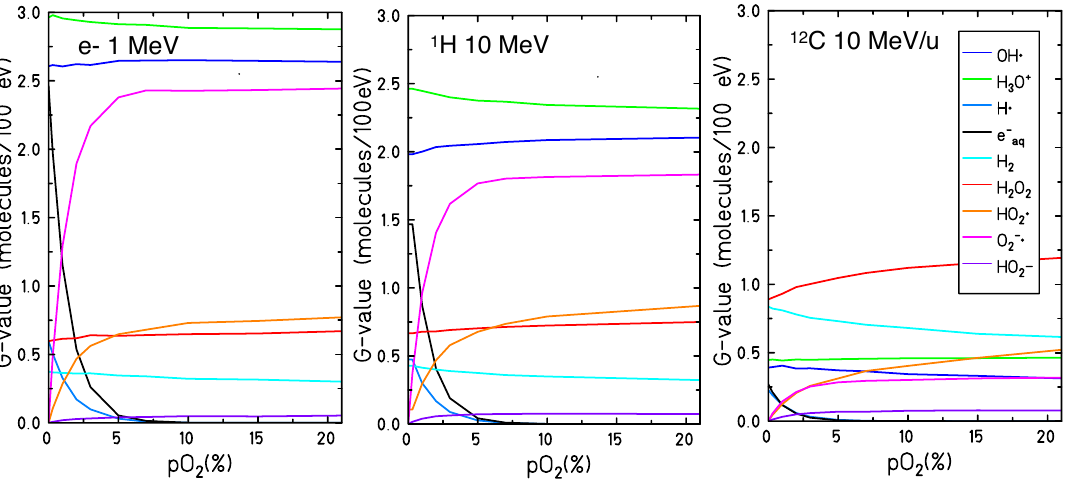
Figure 4. Radiolytic yields, at 1 µ s, for all the different chemical species generated by the water radiolysis at different oxygenation conditions by 1 MeV electron irradiation (LET= 0.13 keV/ µ m) on the left panel and 10 MeV proton (LET= 3.9 keV/ µ m) in the central panel and 10 MeV/u carbon ions radiation (LET= 133 keV/ µ m) on the right panel.